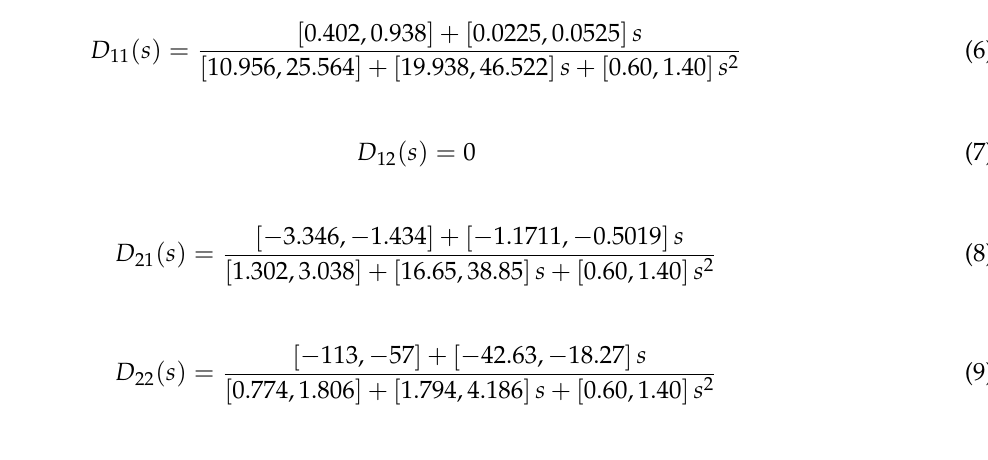
Table 1. Parameters at salinity of 3000 µ S/cm.